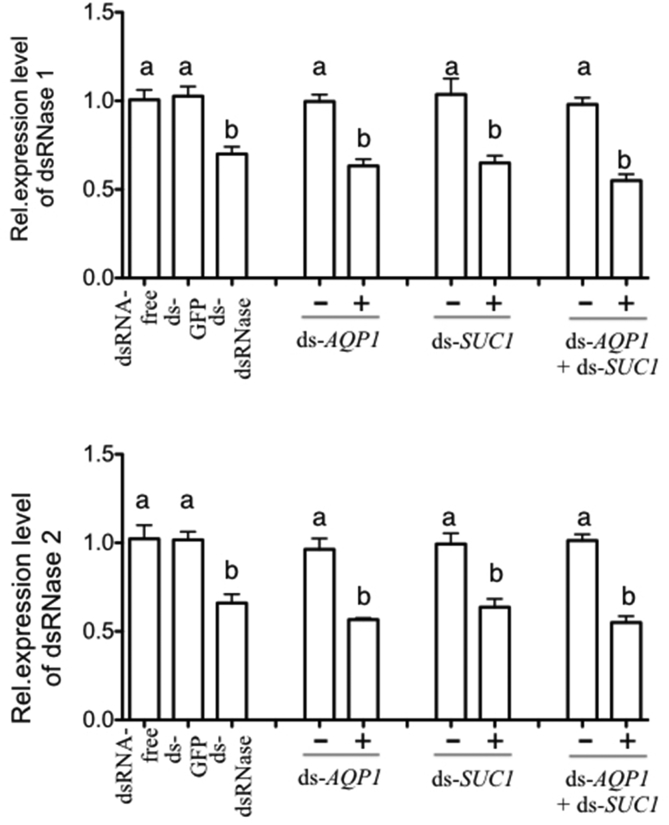
Expression of dsRNase genes in adult whiteflies reared for 6 days on artificial diets supplemented with ds-dsRNase1&2 (+), with ds-dsRNase1&2-free diets (−) as control. (A) Relative expression level of dsRNase1 (B) Relative expression level of dsRNase2. Gene expression was normalized to RPL13, and mean ± s. e. from 3 replicates are shown. Different letters indicate significantly different treatments by post hoc test following one-way ANOVA.